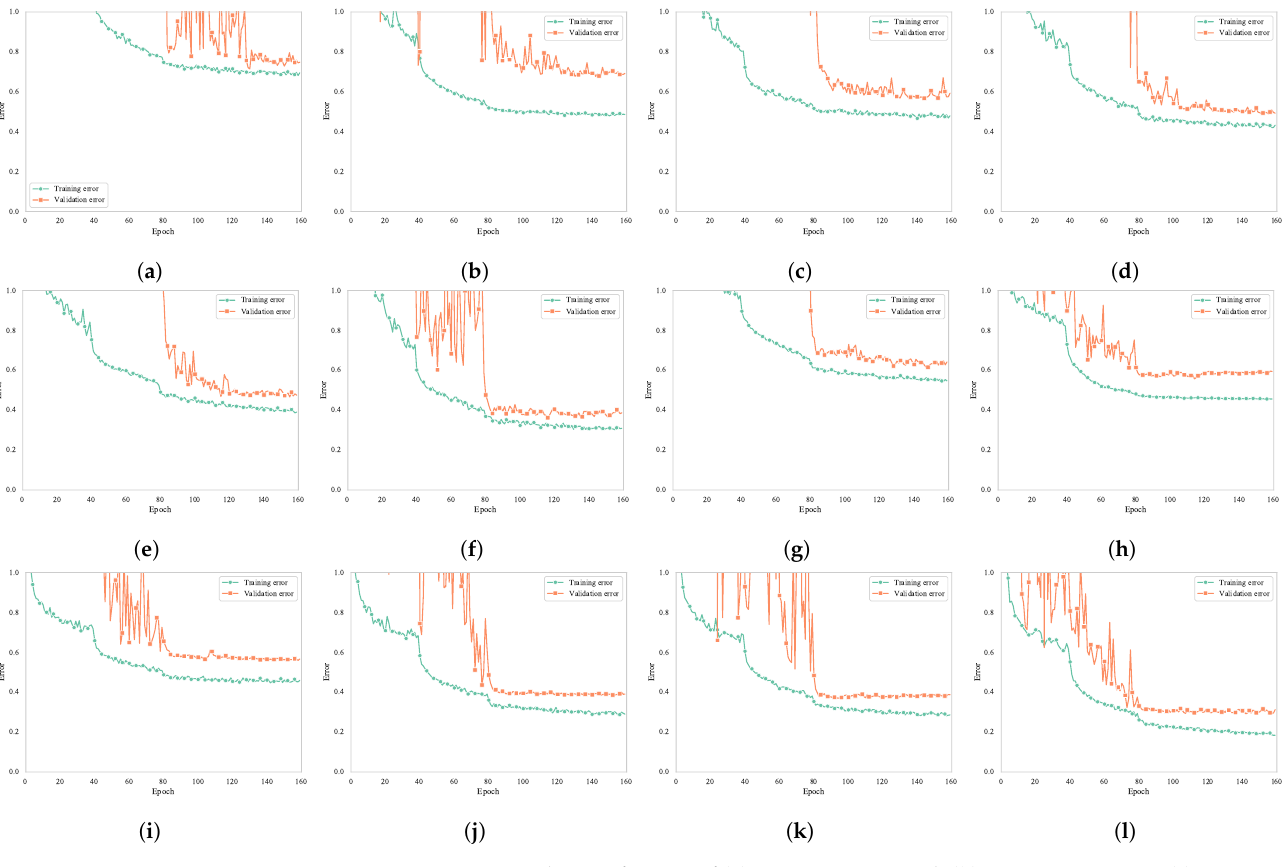
Figure 8. Variation tendency of errors of ( a ) ConvNet-Sigmoid, ( b ) ConvNet-PReLU, ( c ) ConvNet- ReLU, ( d ) ConvNet-ELU, ( e ) ConvNet-SELU, ( f ) ConvNet-SofT, ( g ) ResNet-Sigmoid, ( h ) ResNet- PReLU, ( i ) ResNet-ReLU, ( j ) ResNet-ELU, ( k ) ResNet-SELU, and ( l ) ResNet-SofT when the number of blocks equals